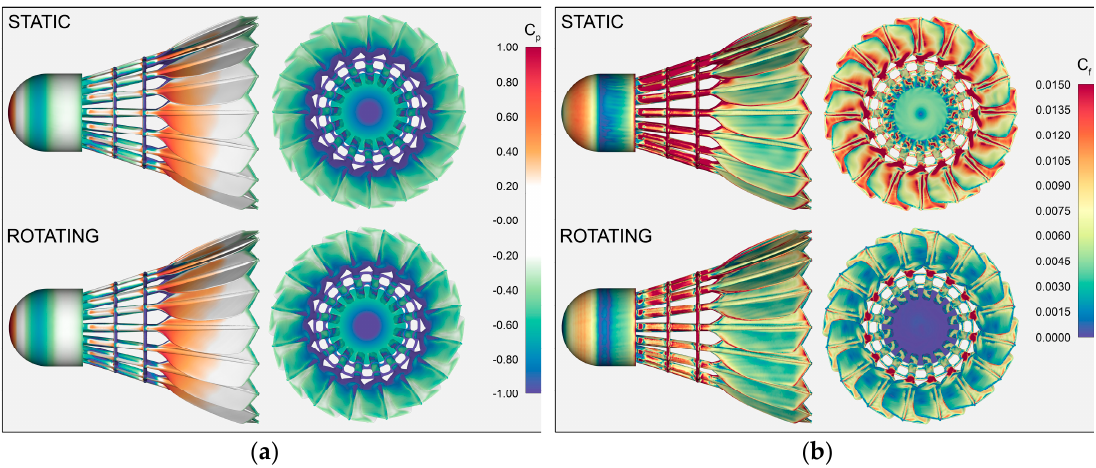
Figure 3. ( a ) Contours of mean C p , Re = 2.7 × 10 5 ; ( b ) contours of mean C f , Re = 2.7 × 10 5